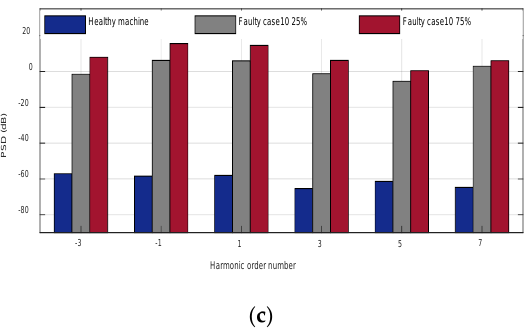
Figure 32. Faulty case 10: ( a ) PMSM current spectra normalized plot under 25%; ( b ) PMSM current spectra normalized plot under 75%; ( c ) ASBCs harmonics variations.